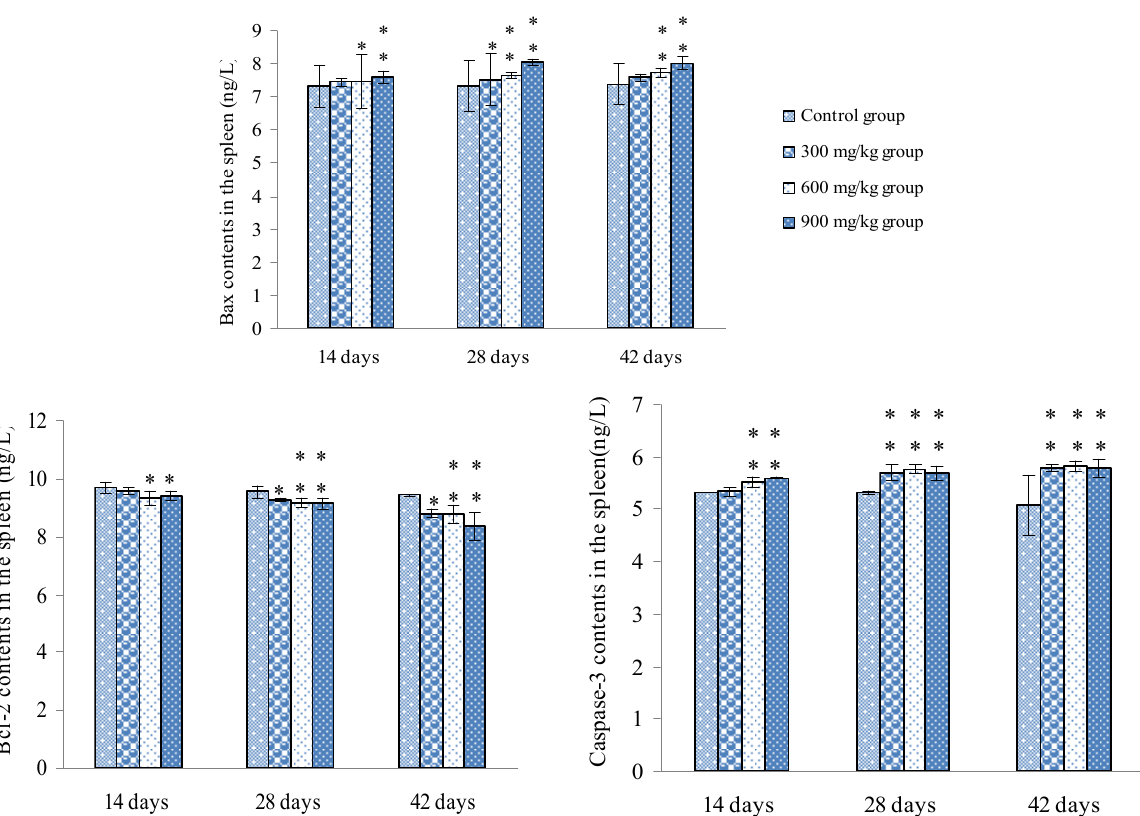
Figure 7. Changes of Bax, Bcl-2 and Caspase-3 contents in the spleen.